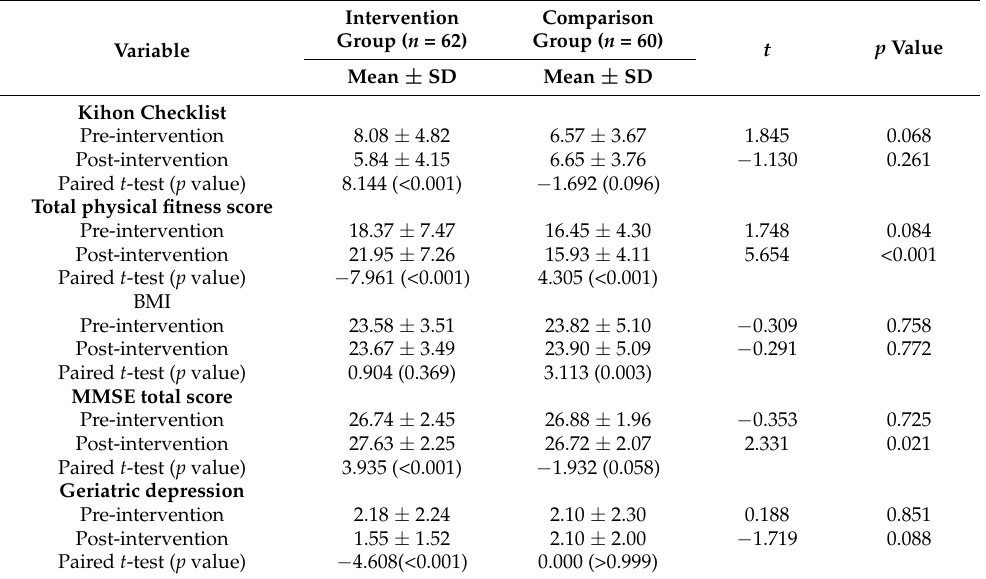
Table 2. Comparison of pre- and post-intervention effectiveness between the two groups.